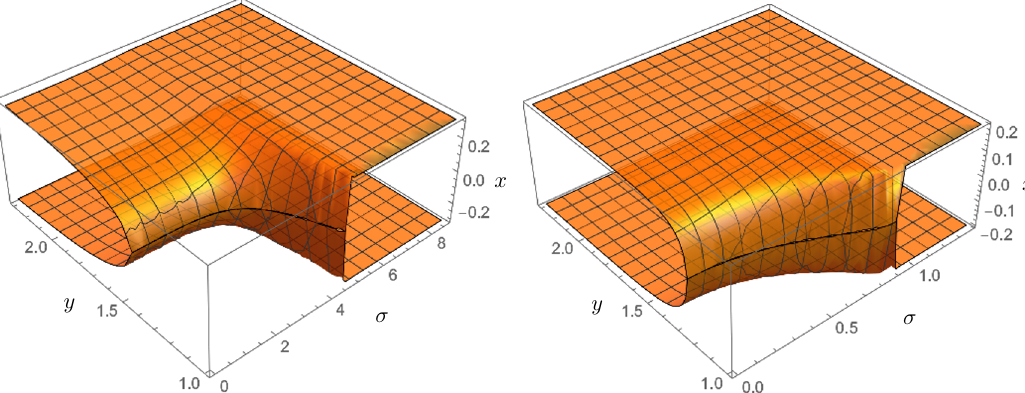
Figure 10 . Plots for the bounce profile x ( y, σ ) in two cases: ˜ L = 0 . 62 (left) and ˜ L = 0 . 4 (right). The configurations smoothly interpolate between U-shaped profiles at σ = 0 and disconnected branes at σ → ∞ . The solution on the left can be regarded as a thin wall bubble: a U-shaped configuration very close to the true vacuum exists for a finite range of σ which then rapidly evolves into the false vacuum. On the other hand, the embedding on the right can be considered as a thich wall configuration.